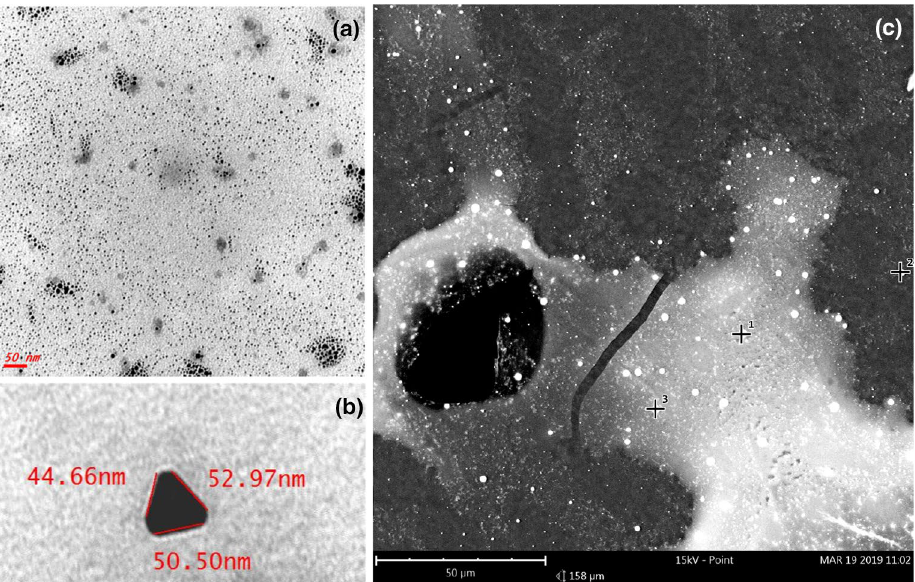
Figure 1. ( a ) TEM of filtered SUNc in ultra-pure water (0.22 μm). ( b ) A magnification SUNc TEM image not filtrated. ( c ) Scanning electron microscopy analysis of SUNCs. Magnification: × 85,000 (scale bar: 10 μm–15 kV). Spots 1, 2, and 3 revealed different distribution of elements in the sample-different phases according to the SEM elemental